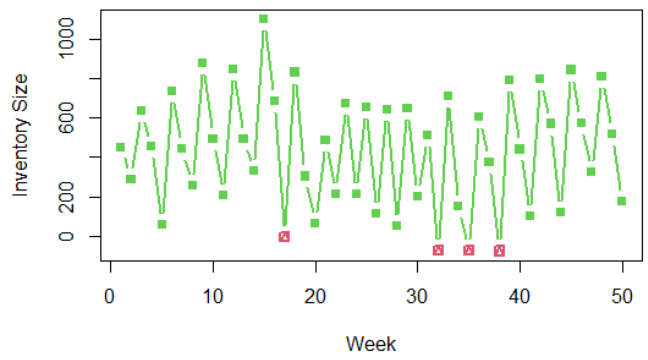
Figure 4. Inventory level according to initial plan with a service level of 95%.